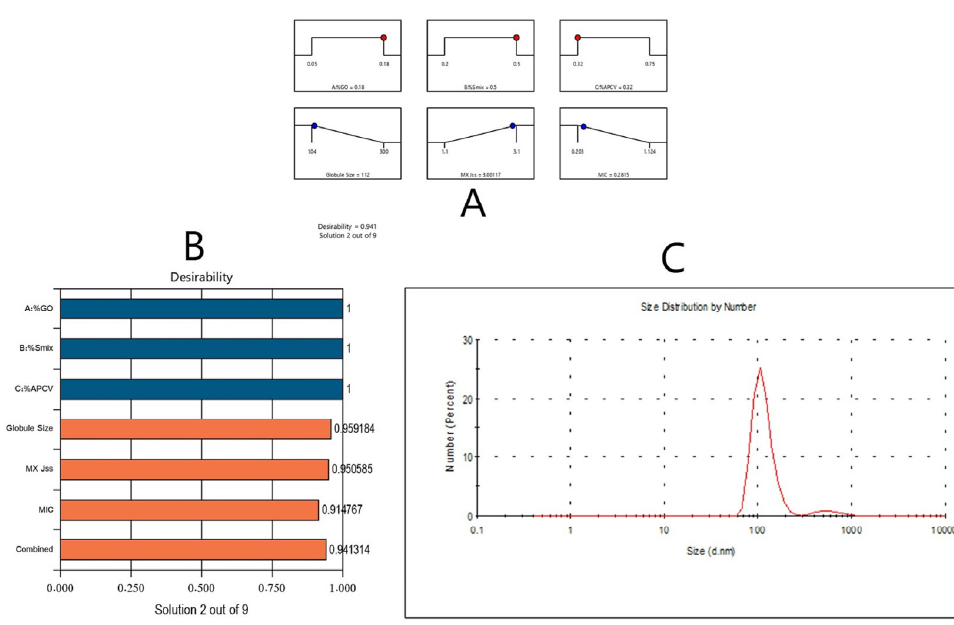
Figure 3. Bar chart, desirability ramp, and DLS distribution for the optimization process. The desirability ramp illustrates the levels of study factors and expected values for the dependent variables of the optimized OEO-SNED ( A ). The bar chart illustrates the values of desirability for the conjugated responses ( B ). The DLS distribution indicated droplet size for the optimized formula ( C